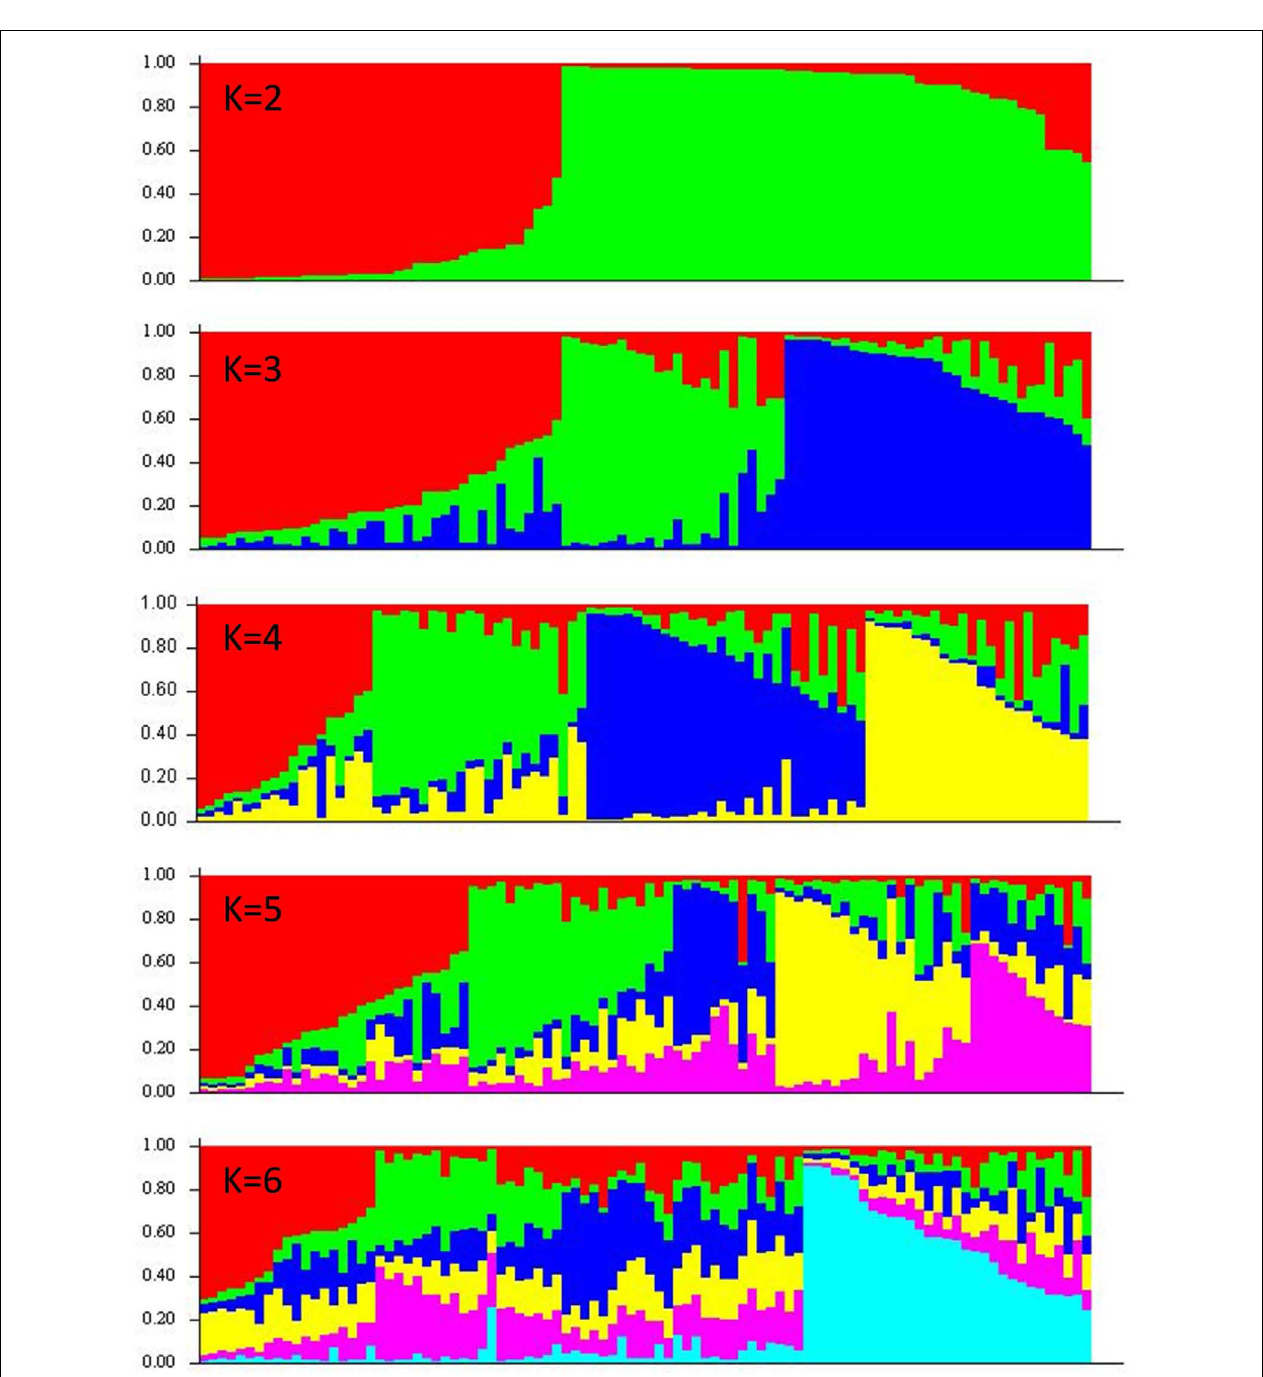
FIGUREA1 | Presentation of the population structure of 96 B. napus accessions of panel 1 under the assumption of subpopulation K = 2–6 which calculation based on 24 SSR markers.